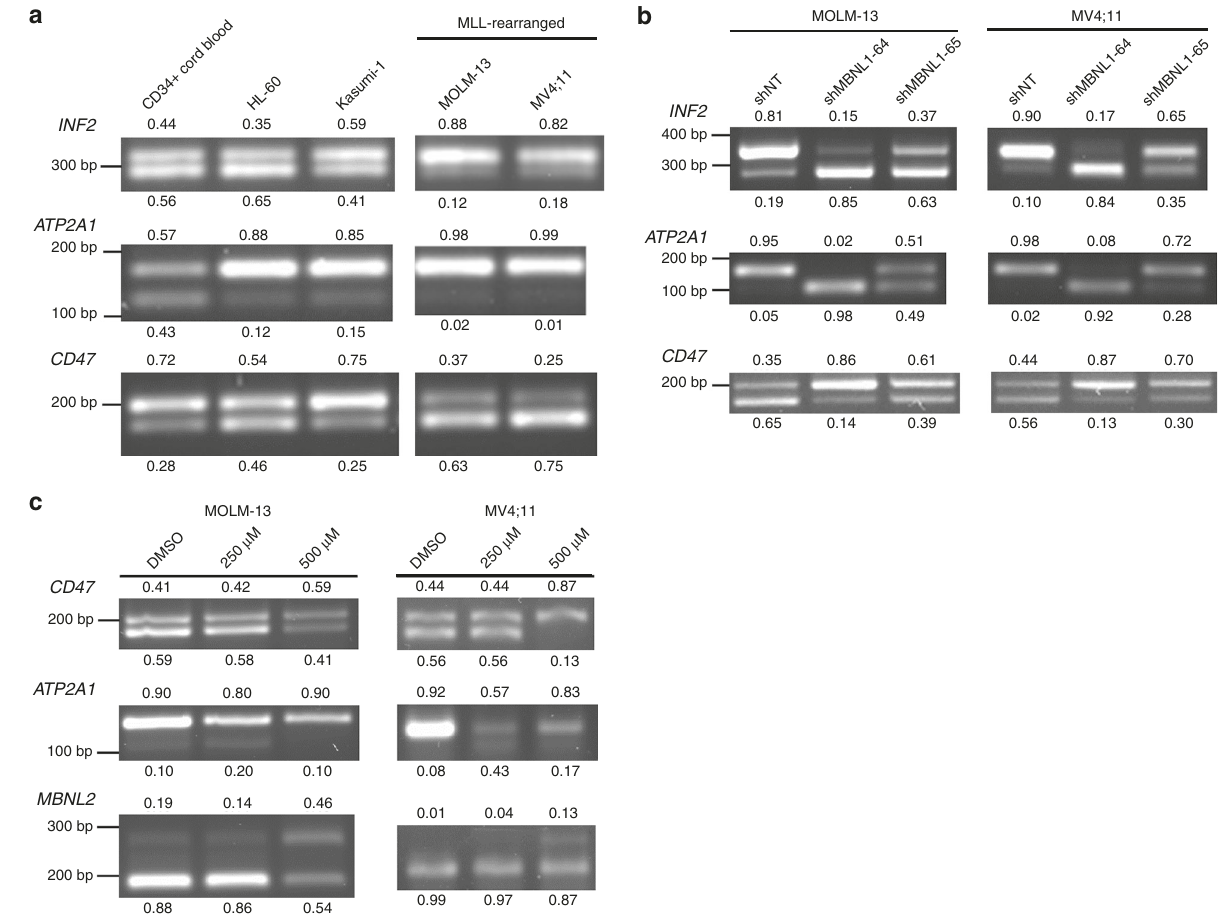
Fig. 5 MBNL1-regulated alternative splicing is active in leukemic cells. a RT-PCR analysis of regions of select MBNL1 regulated genes ( INF2, ATP2A1 , and CD47 ) across a panel of MLL-rearranged and wild-type leukemia cells. b RT-PCR analysis of INF2 , ATP2A1 , and CD47 transcripts demonstrating change in splicing pattern in MOLM13 cells after MBNL1 knockdown. Band percentages (relative to each individual lane) are noted. c Alternative splicing patterns of MBNL1 target genes are shown after 48 h of Compound 1 treatment at the indicated dosages. Relative proportion of each AS feature indicated in decimal adjacent to corresponding band. All gels are representative images of two biological